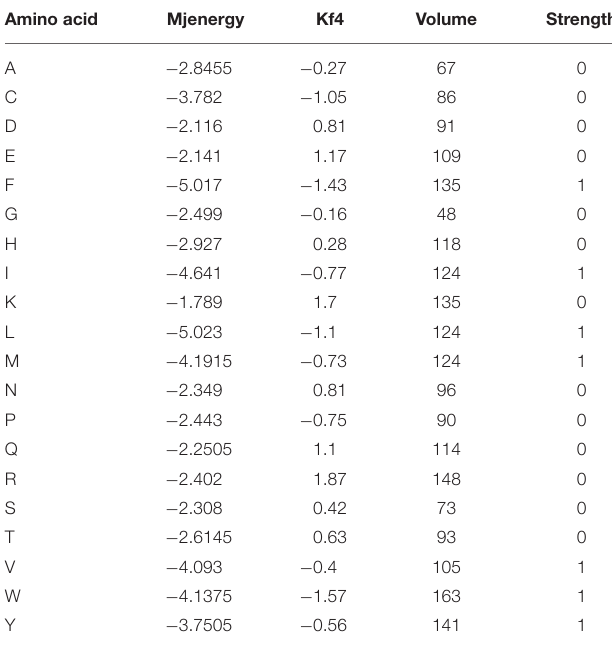
TABLE 3 | Values used for CDR3 amino acid properties